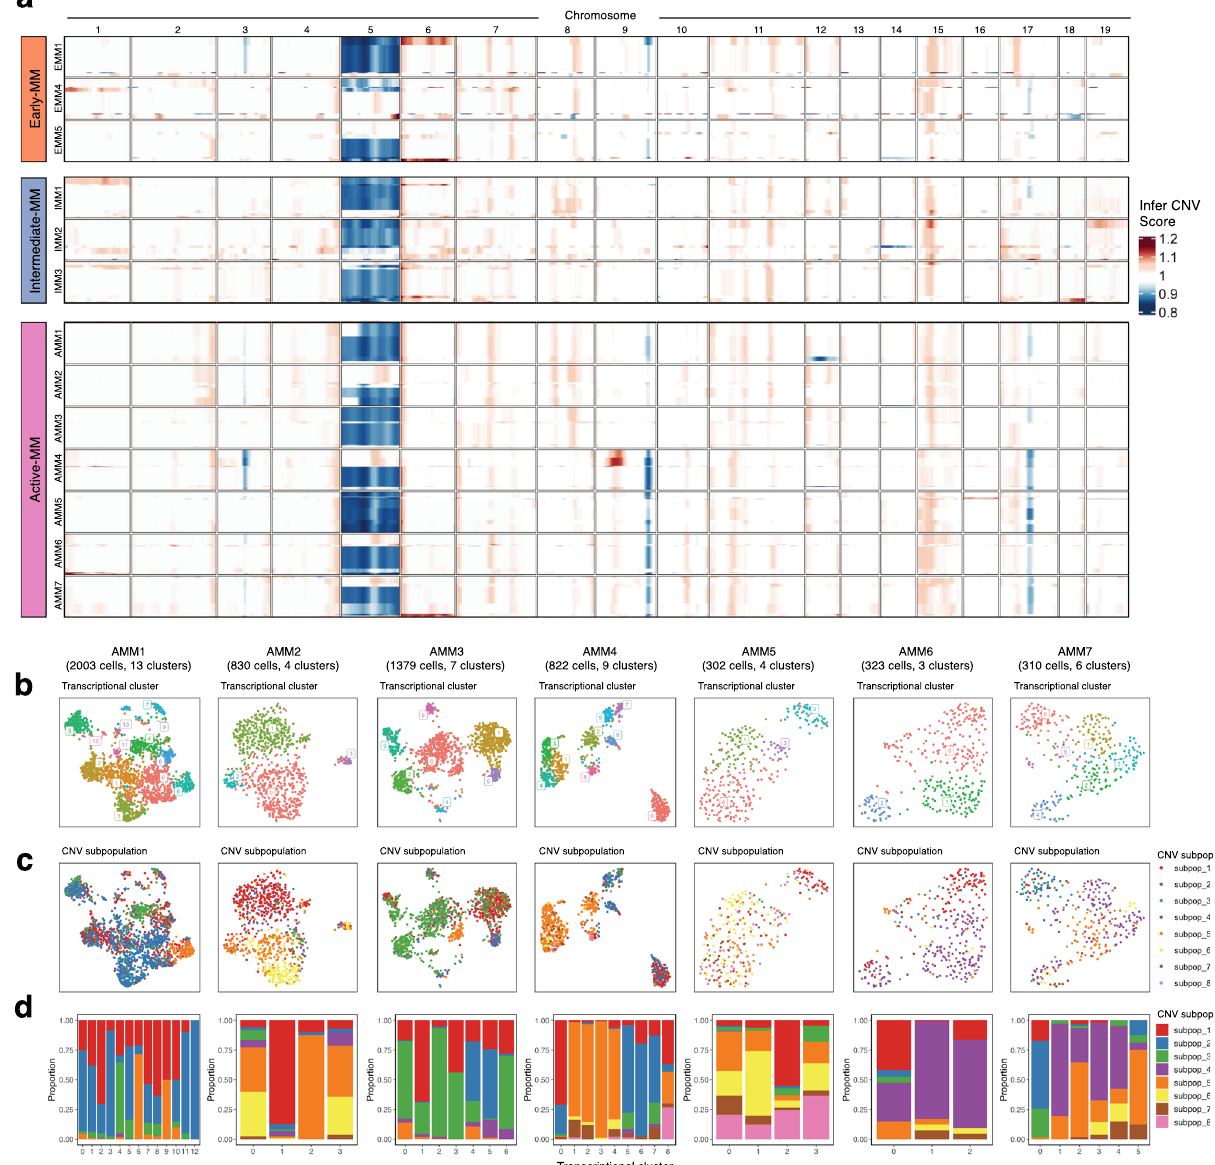
Fig. 3 Drivers of intratumoural heterogeneity in the malignant cell compartment of V κ *MYC mice. a Heatmap of genome-wide copy number variations (CNVs) inferred from scRNA-seq data of malignant plasma cells as determined using InferCNV 34 . Columns represent genome position across chromosomes. Rows represent CNVs averaged by intra-sample CNV subpopulation, which were identi fi ed using the ward.D2 hierarchical clustering/ random forest method implemented by analysis_mode = ‘ subclusters ’ in inferCNV. CNV-driven subpopulation sizes ranged from 1 to 979 cells (median 44). The height of each CNV subpopulation is proportionate to its fractional composition within a given tumour. b UMAP visualization of malignant cells from each active-MM mouse coloured by transcriptional cluster. Gene expression-driven cluster sizes ranged from 10 to 474 cells (median 79). c UMAP visualization of malignant cells from each active-MM mouse coloured by CNV subpopulation. d Bar plot showing the distribution of CNV subpopulations ( fi ll) across transcriptional clusters ( x -axis). Results for ( b – d ) are organized for each active-MM mouse in columns, with subject names and the number of cells/transcriptional clusters listed above. Source data are provided in SourceData_Fig. 3.xlsx. EMM: early-MM, IMM: intermediate-MM, AMM: active-